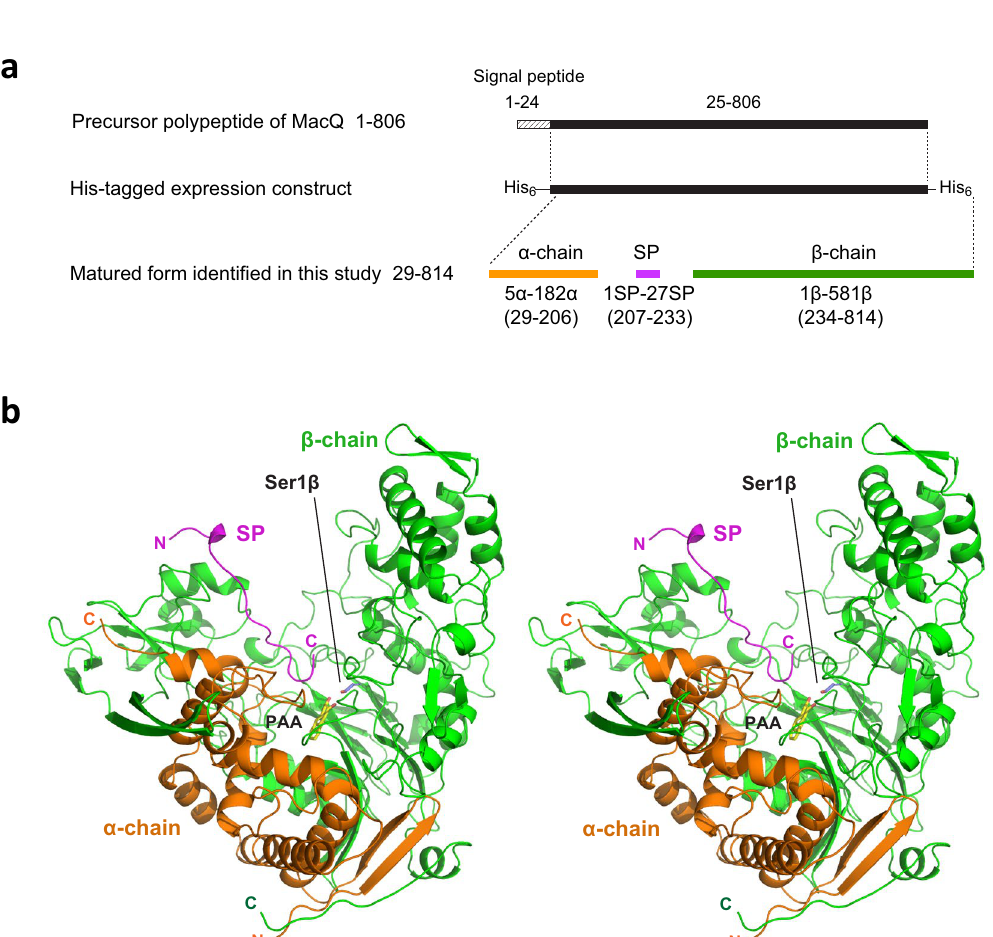
Figure 2. Heterodimeric structure of MacQ. ( a ) Schematic representation of the single MacQ precursor polypeptide and its self-cleaving maturation products. The N-terminal sequencing and MALDI-TOF/MS analysis indicated that the α -chain, SP, and β -chain correspond to residues 5 α -182 α (29–206), 1SP-27SP (207–233), and 1 β -581 β (234–814), respectively. The parentheses refer to the residue number of precursor polypeptide of MacQ including signal peptide sequence. The signal peptide (residue 1–24) was predicted with the SignalP 4.1 program (http://www.cbs.dtu.dk/services/SignalP/). ( b ) Stereo-view ribbon diagram of MacQ heterodimer with the SP generated by self-cleaving activity of a MacQ precursor single polypeptide chain. The α -chain, SP, and β -chain are coloured in orange, magenta, and green, respectively. The bound PAA and the catalytic Ser1 β are also shown as stick models in yellow and blue, respectively, and are